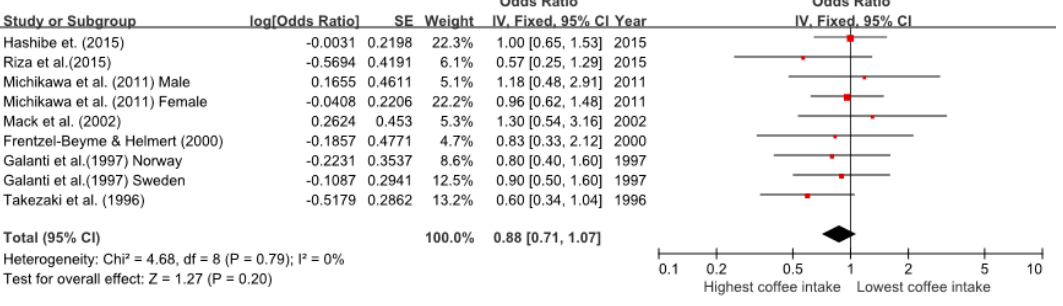
Figure 2. Forest plot of effect estimates from studies on coffee consumption and thyroid cancer risk.